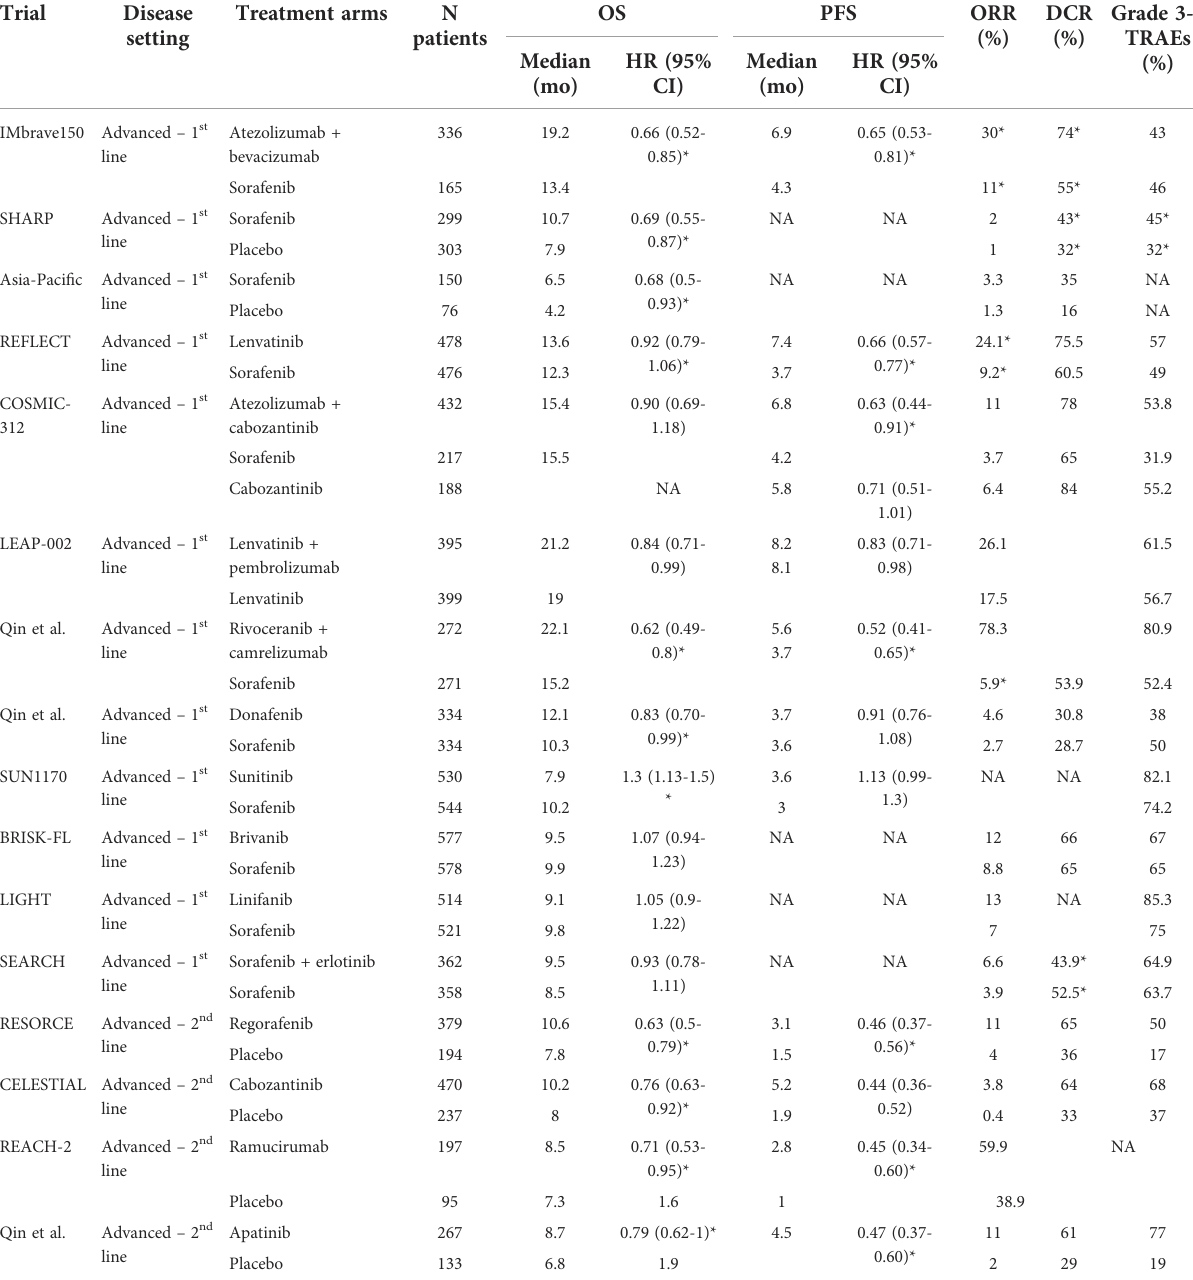
TABLE 2 Overview of selected phase III trials evaluating anti-angiogenic agents in advanced HCC. Trial Disease